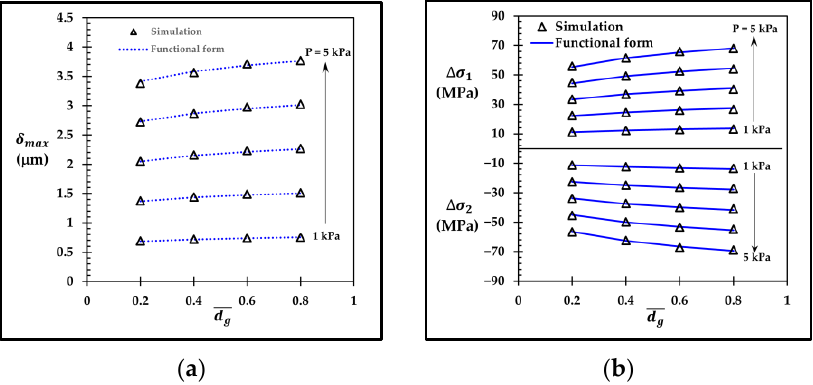
Figure 26. Comparisons of simulation results with ( a ) functional form of maximum deflection 𝛿 𝑚𝑎𝑥,𝐴𝐺2−𝑇𝑜𝑝 and ( b ) functional forms of averaged stress differences ∆𝜎 1,𝐴𝐺−𝑇𝑜𝑝 and ∆𝜎 2,𝐴𝐺−𝑇𝑜𝑝 .